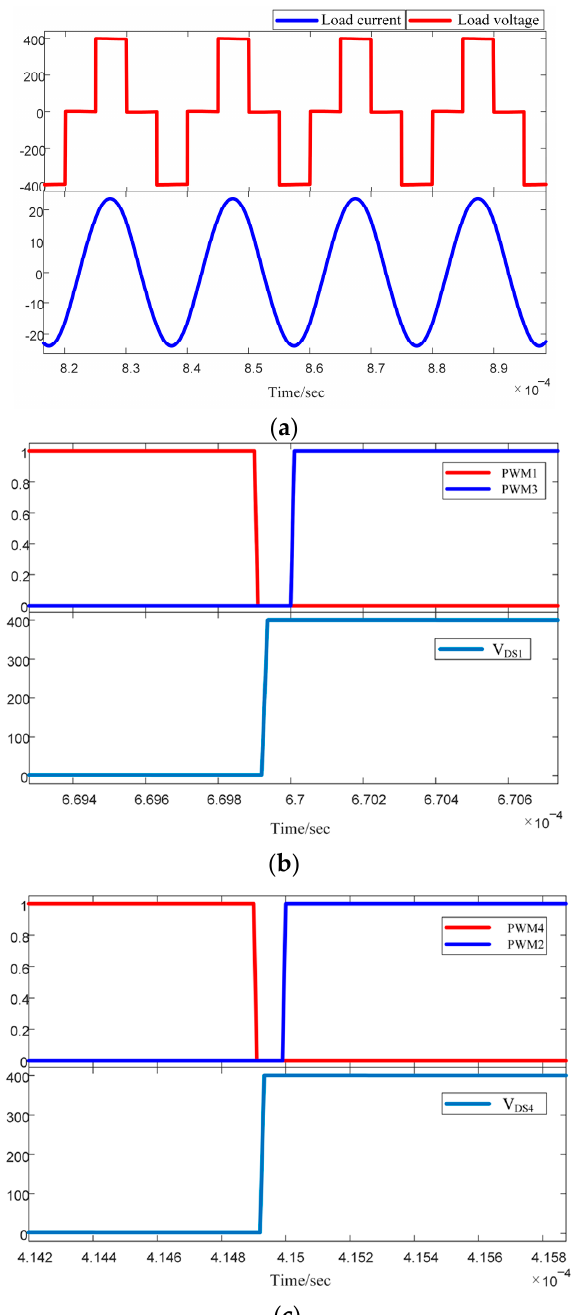
Figure 14. Main waveforms of the inverter under high power level. ( a ) Load voltage and current waveform; ( b ) Q 1 Q 3 trigger signal and Q 1 drain-source voltage waveform; ( c ) Q 2 Q 4 trigger signal and Q 4 drain-source voltage waveform.